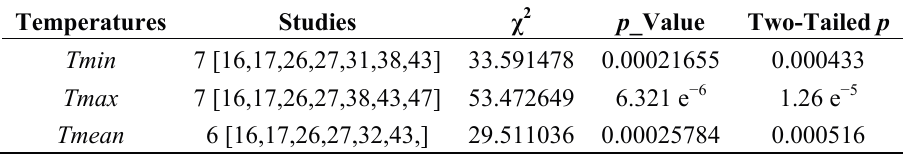
Table 3. Combined p -values for temperatures and dengue.